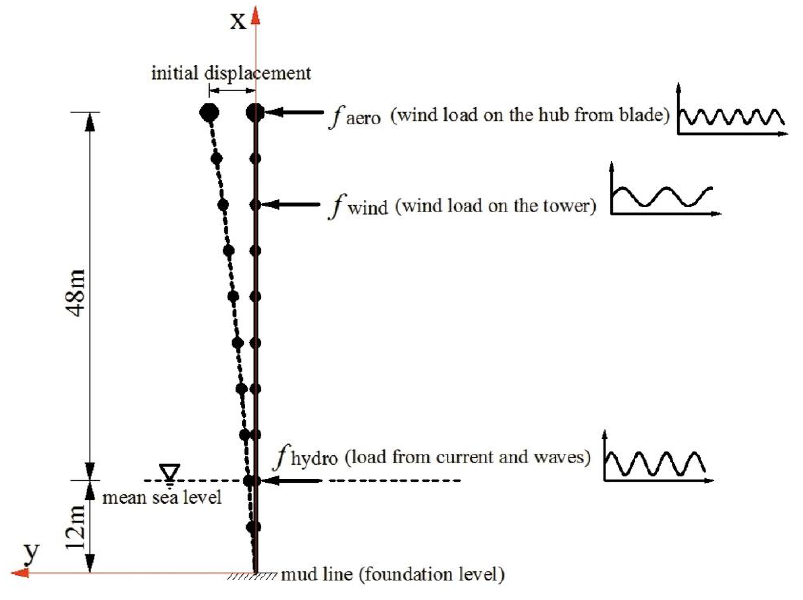
Figure 1. A sketch of a monopile-supported wind turbine.